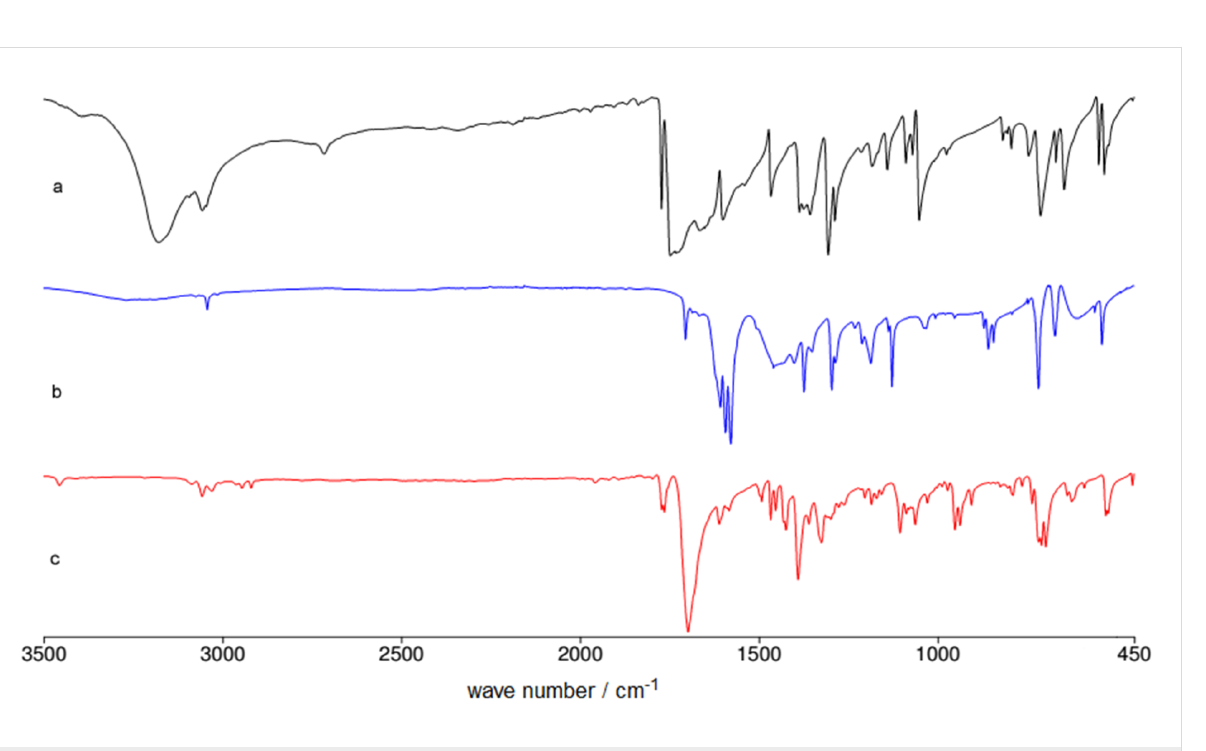
Figure 2: Ex situ IR spectroscopy of the reaction of 12 and benzyl bromide in the ball mill: a) phthalimide 12 ; b) first step: phthalimide + K 2 CO 3 , 1 h milling; c) second step: addition of benzyl bromide, LAG DMF and further 1 h